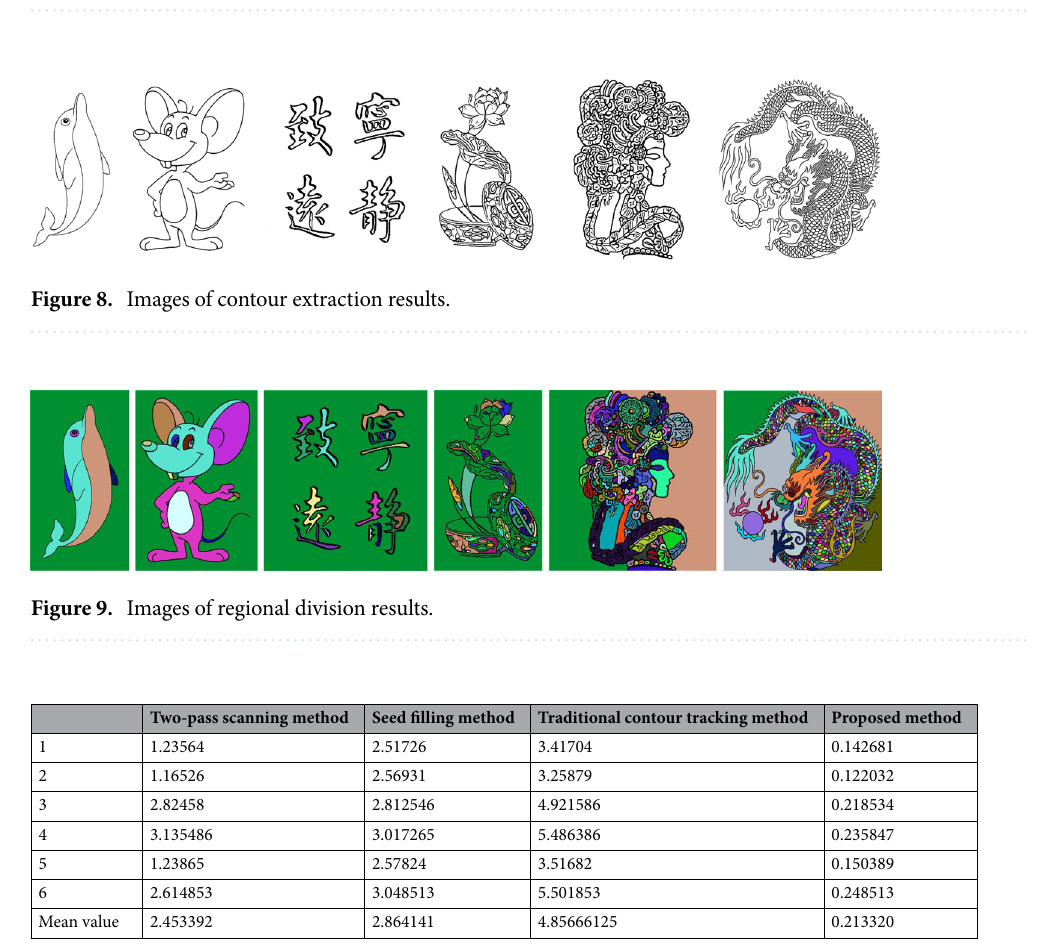
Figure 7. Original images.